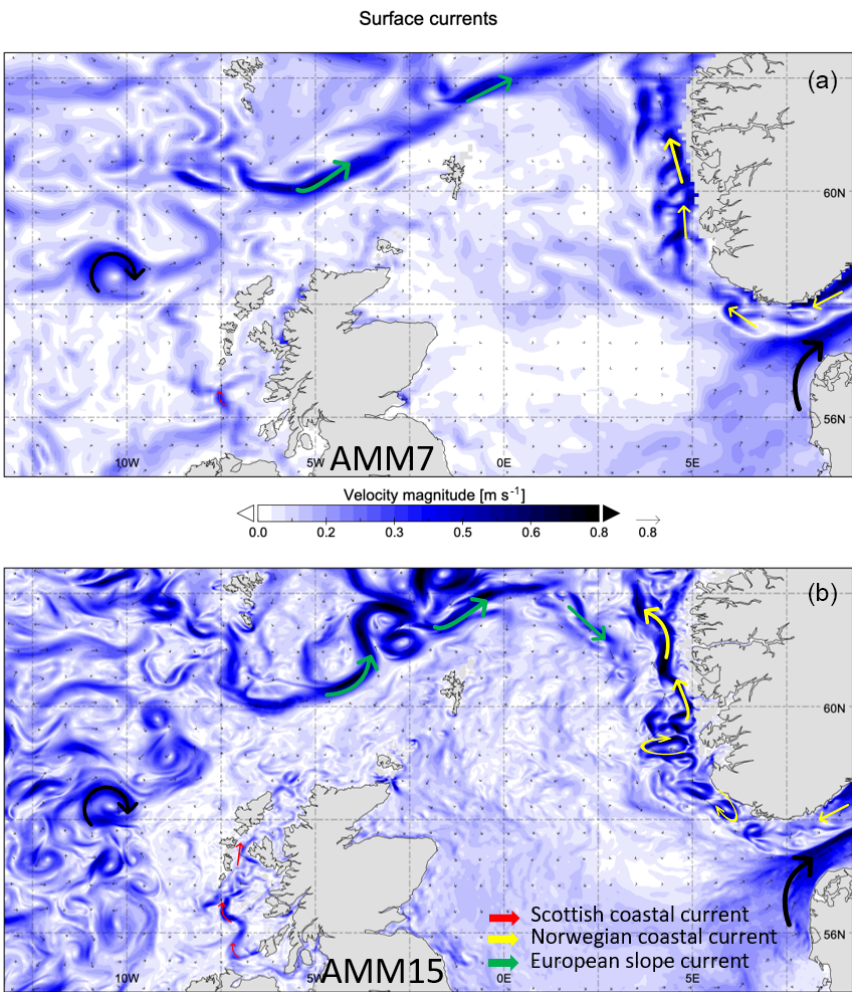
Figure 3. Surface current from AMM7 (a) and AMM15 (b) (daily mean of 2 December 2018).